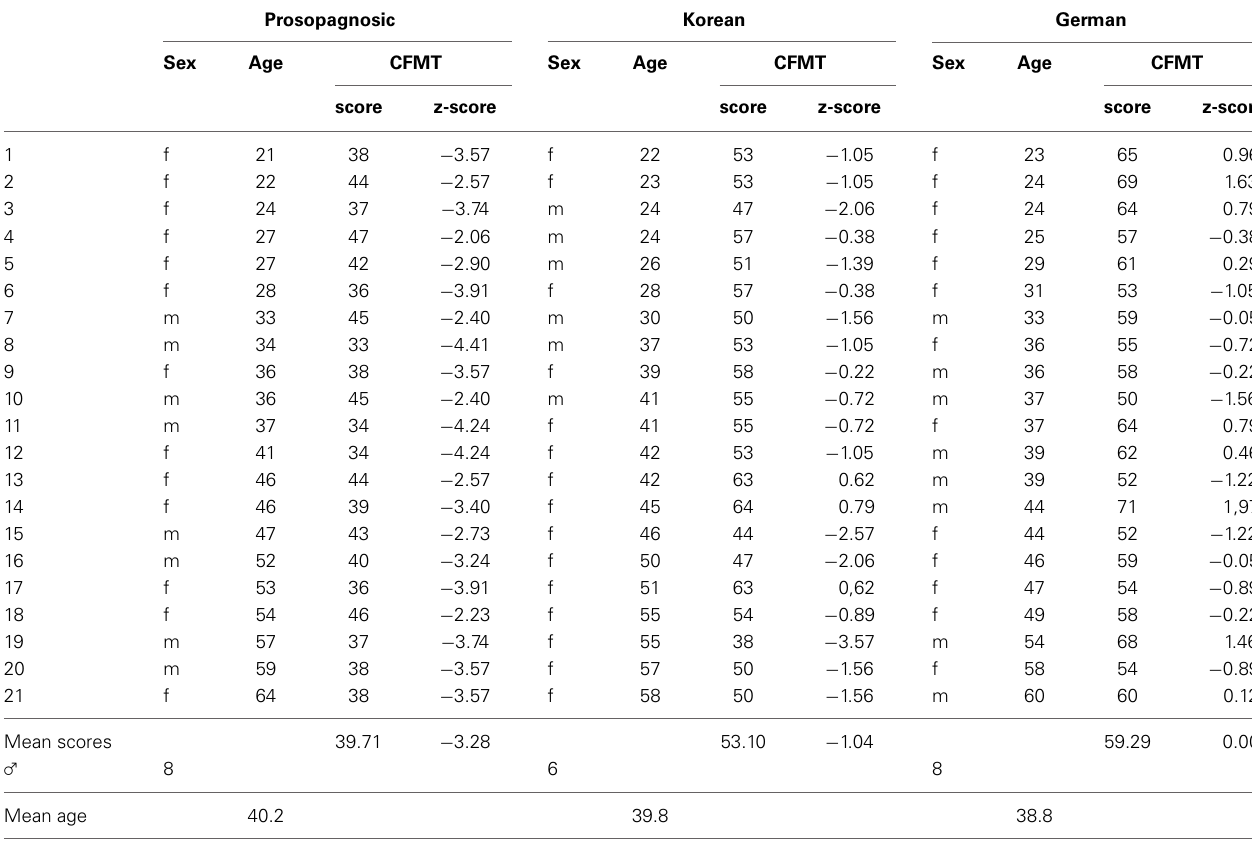
Table 1 | Overview of the participants in the three different groups. Prosopagnosic